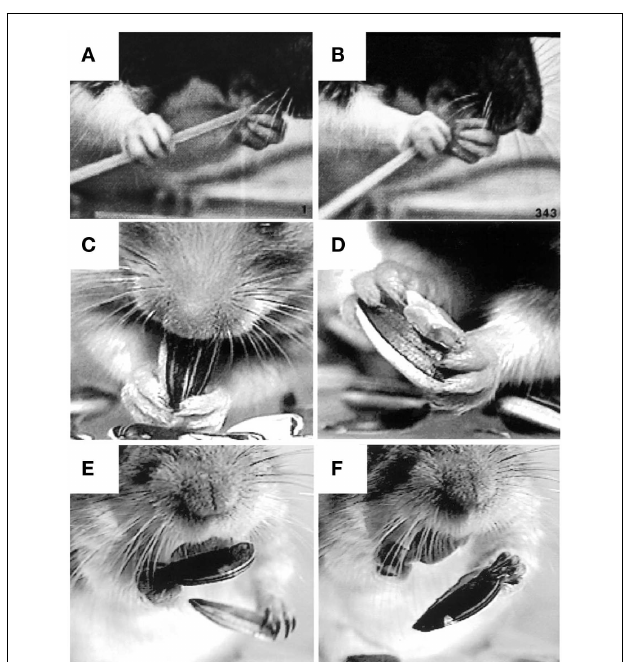
FIGURE 8 | Representative still frames illustrating specialized grip configurations and independent digit movements in rodents during food handling . (A,B) A rat eating uncooked spaghetti, the left hand holds the pasta near the mouth with the digit tips (a modified precision grip) while the right hand uses a scissor grip between digits 4 and 5 to push the pasta toward the mouth. (C,D) A hamster eating a sunflower seed, both hands hold the seed in a modified precision grip between digit 1 (the thumb) and digits 2 and 3 as the mouth bites into the shell.Two objects can also be held at once, the seed is held in a modified (bilateral) pincer grip between digits 1 and 2, the shell is held in a bilateral power grip between the palm and digits 3 and 4, while digit 5 is positioned on the ventral surface of the seed, likely to stabilize the grip on both objects. (E,F) A Mongolian gerbil eating a sunflower seed. A bite from the incisors is used to open the shell (not shown).The bottom half of the shell is held in the digit tips as the left hand uses a precision grip to grasp and discard the top portion of the shell.The left hand then grasps the bottom half of the shell in the digit tips (precision grip) and discards it as the right hand uses a precision grip to hold the seed in the mouth. Adapted from Whishaw et al. (93),Whishaw et al.